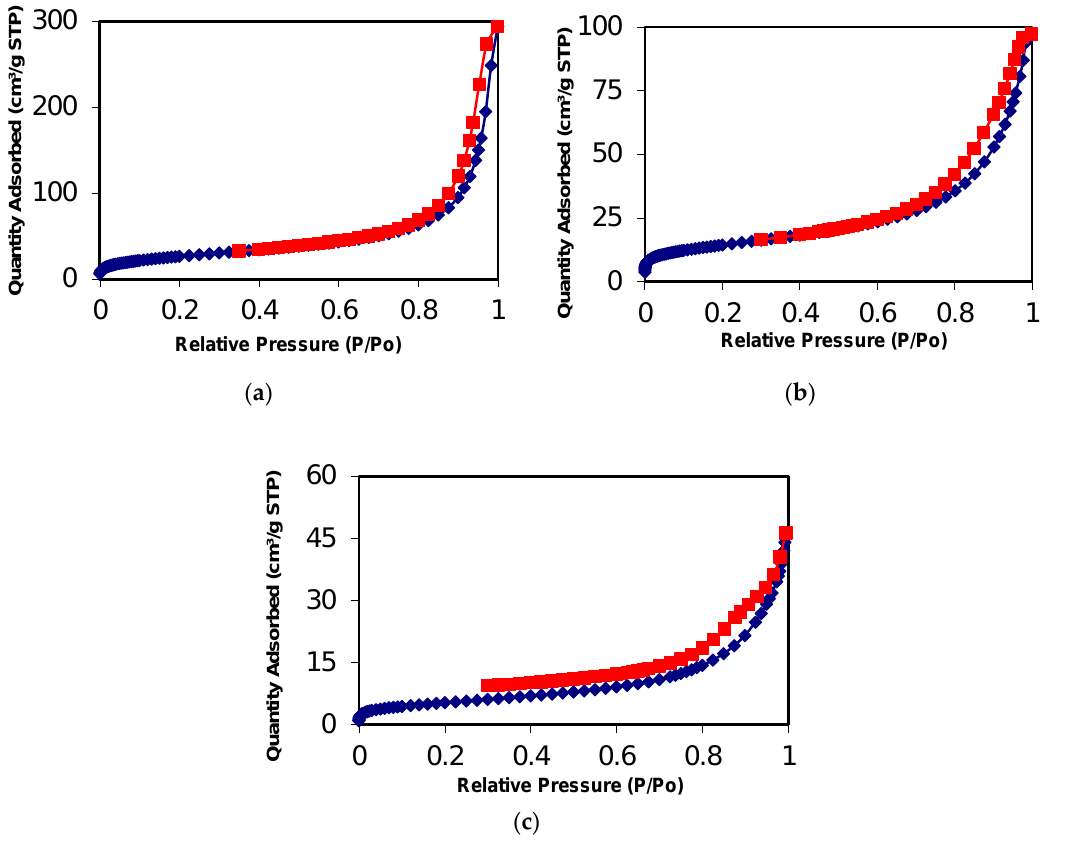
Figure 6. Nitrogen adsorption isotherm of materials synthesized by ( a ) Method 1 (1-PSTH), ( b ) Method 2 (2-PSTH) and ( c ) Method 3 (3-PSTH). Adsorption (blue line) and desorption (red line) processes. Table 1. Morphological information of the synthesized materials.